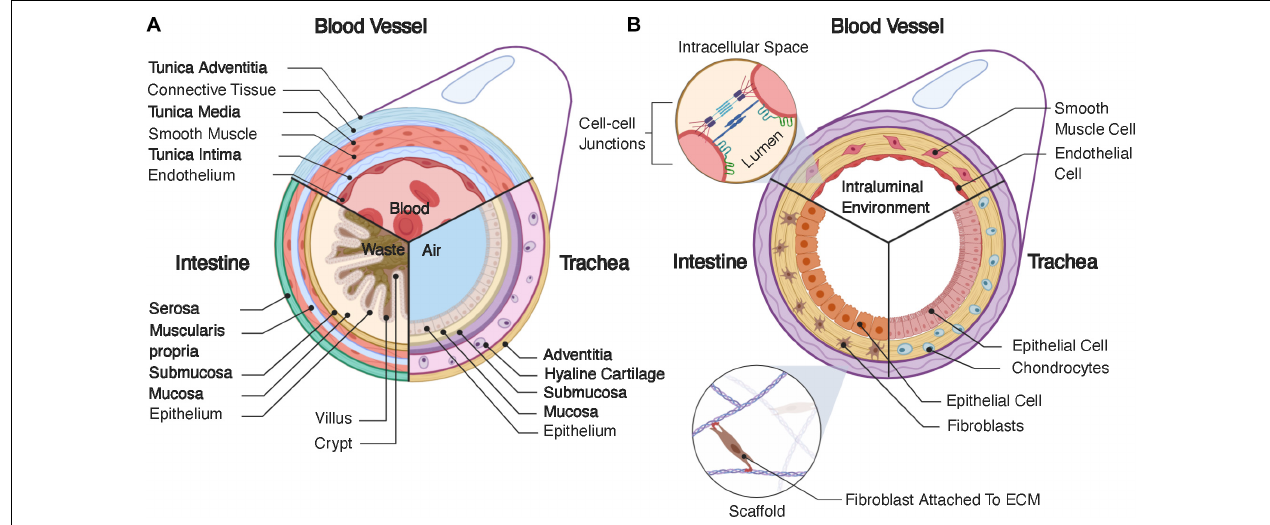
FIGURE 1 | (A) Structure of native tubular tissue systems. Specifically, this schematic highlights the structure of vasculature, the intestines, and the trachea. (B) Typical structure for tissue engineered tubular systems corresponding the native systems in (A)